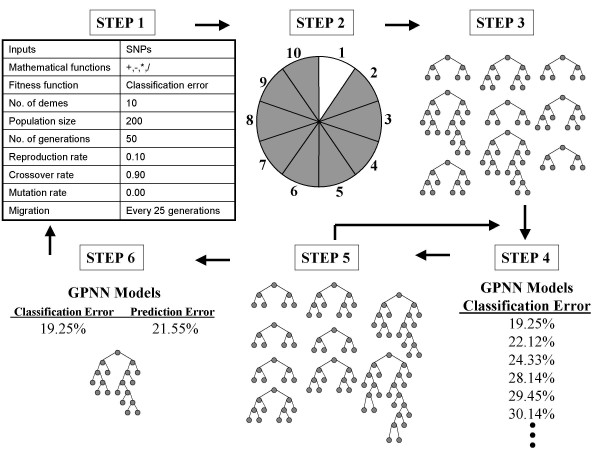
Overview of GPNN Method.